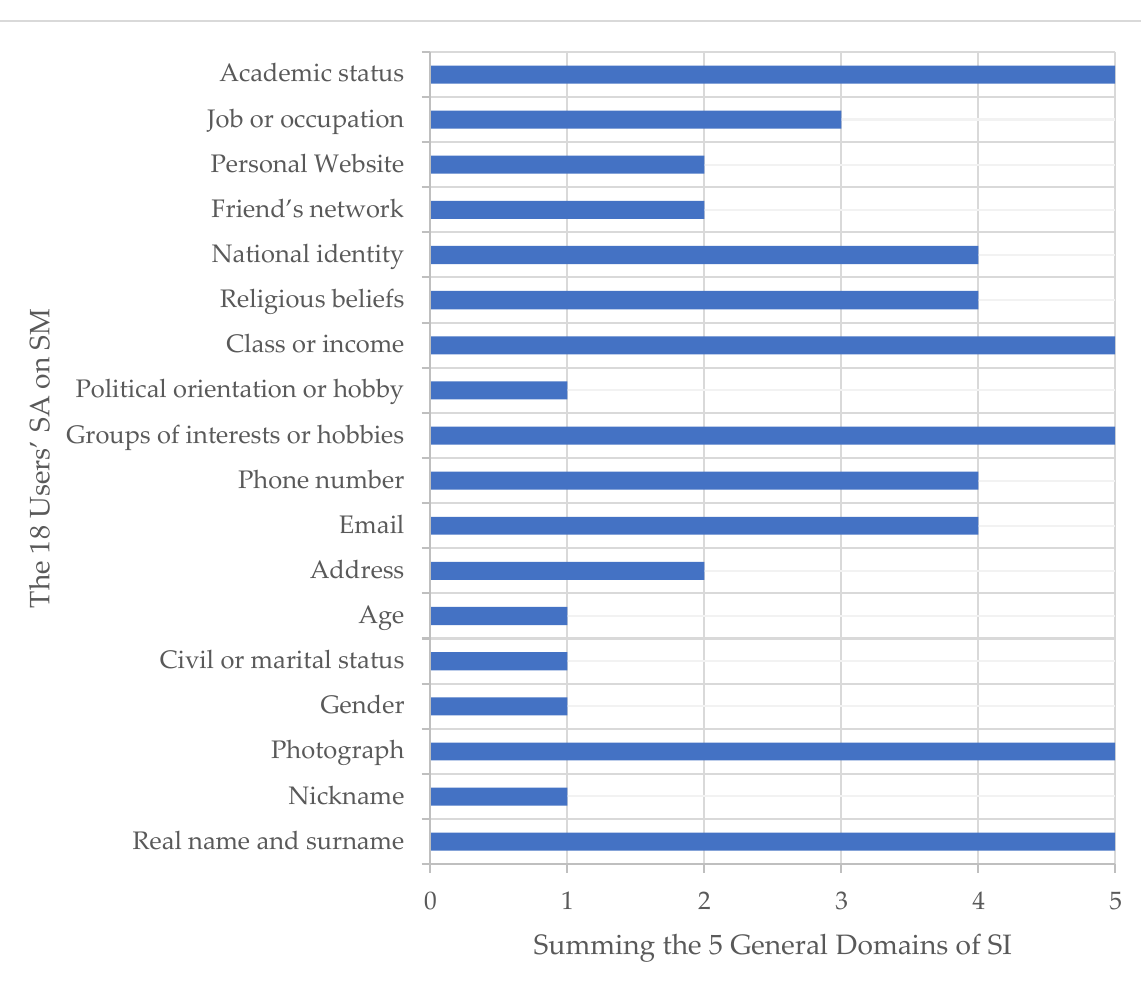
Figure 4. The Most Revealing Social Domains on Social Media.